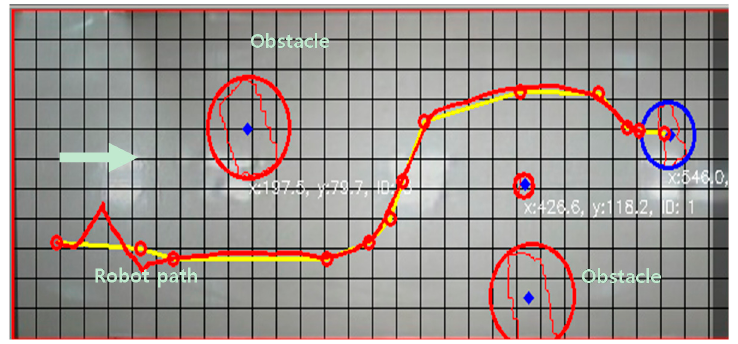
Figure 19. Experimental results of the robot’s path control using the proposed localization method.